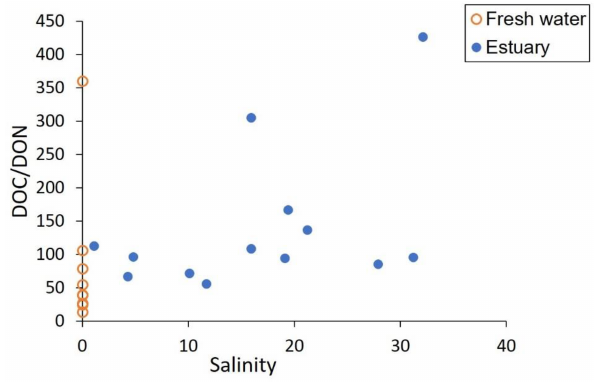
Figure 7. DOC / DON ratio distribution pattern along with salinity in the Rajang. For fresh water and estuary, the mean DOC / DON value was 50 and 140, respectively. DON concentrations are taken from Jiang et al.